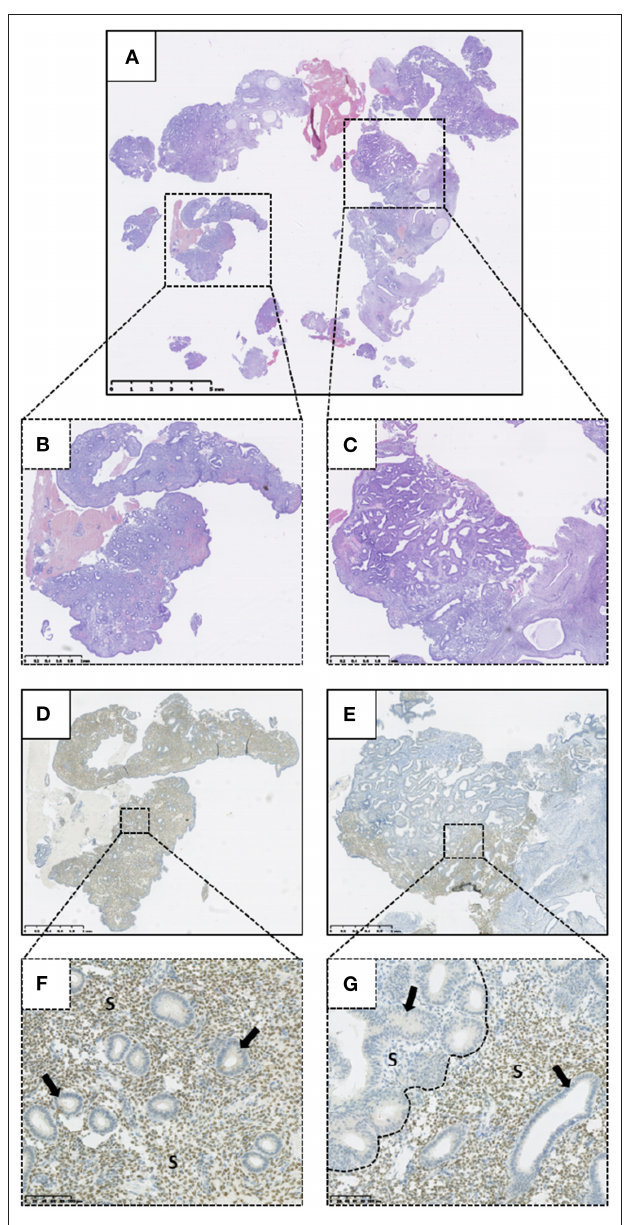
FIGURE 4 | Immunohistochemical expression of HAND2 protein within a tissue biopsy specimen demonstrating Endometrial Intraepithelial Neoplasia (EIN). (A) Haematoxylin and Eosin (H&E) stained biopsy specimen containing EIN. (B) Higher power representative background endometrium from (A) . (C) Higher power EIN lesion from (A) . (D) HAND2 immunohistochemical staining of (B) . (E) HAND2 immunohistochemical staining of (C) . (F) Higher power image of D demonstrating positive (scored as > 50%) HAND2 stromal nuclear staining within the background endometrium. (G) Higher power image of E demonstrating absent (scored as 0%) HAND2 stromal nuclear staining within an EIN lesion (left of dashed line). Junctional region marked with dashed line. Positive HAND2 ( > 50%) staining of background endometrium to right of dashed line. Arrows highlight representative endometrial glands. S, Stroma. Varying magnifications—see scale bars.